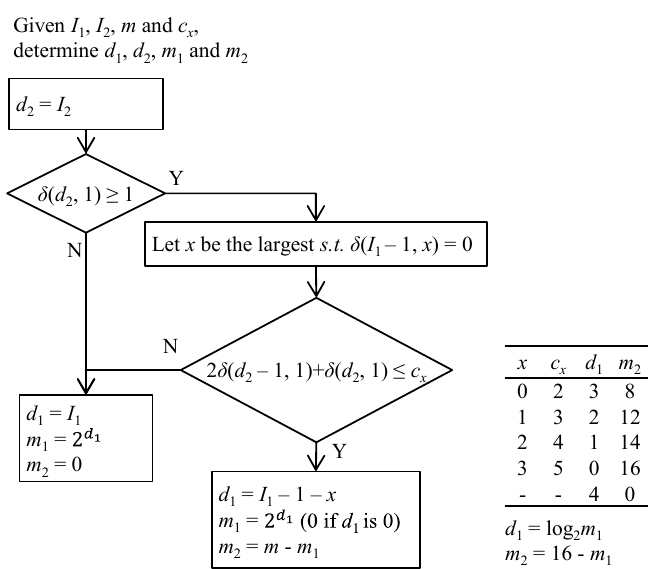
Figure 7. The algorithm for determining the size of each Bloom filter.